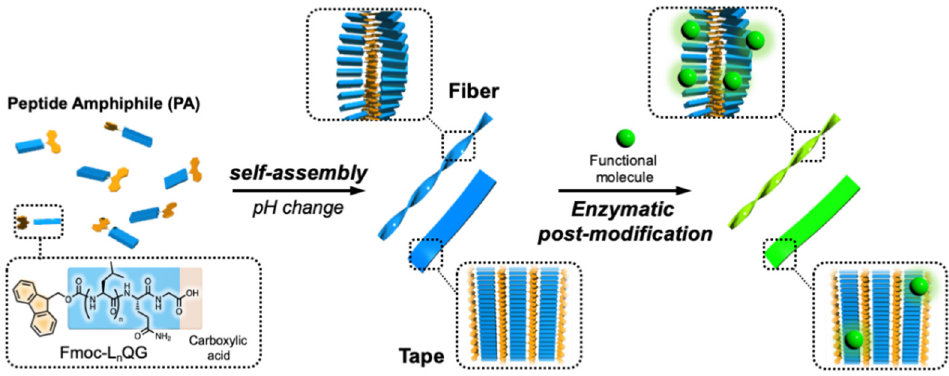
Figure 1. Conceptual diagram of this study. Short aromatic peptide amphiphiles bearing enzymatic reaction sites first self-assemble into different structures, then post-modification of the structures was achieved by the enzymatic reaction.